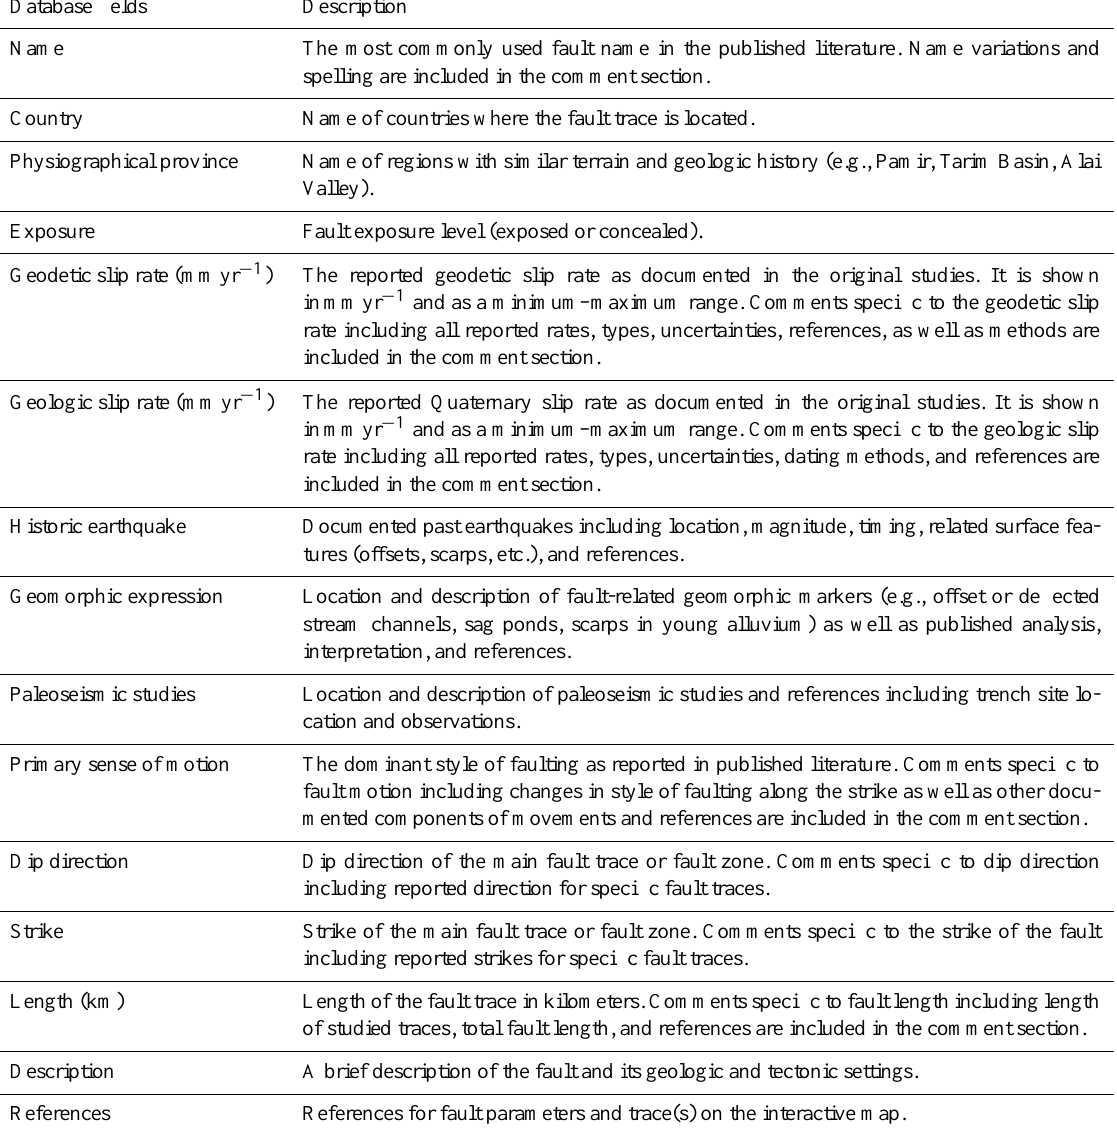
Table 3. Description of parameters and fields used in the